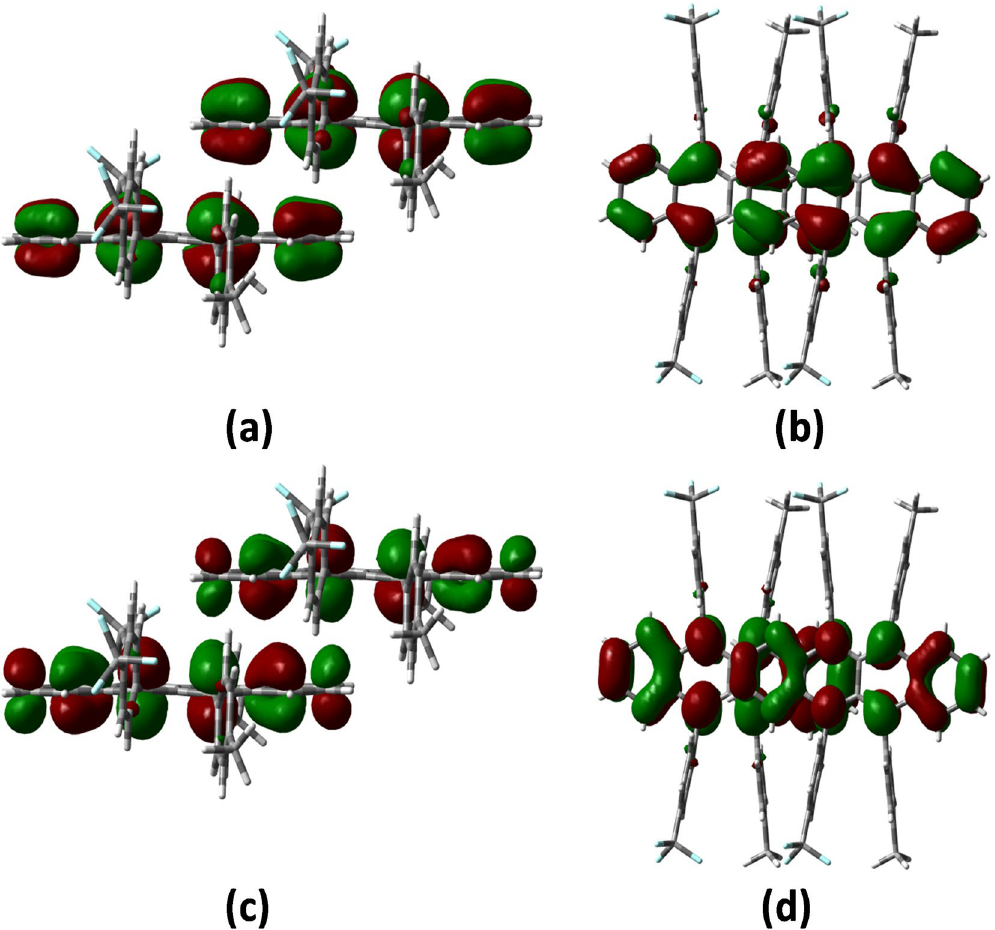
Figure 4. HOMOs (0.02 au) for P dimers of fm-rubrene in side view ( a ), and in top view ( b ); and LUMOs (0.02 au) for P dimers of fm-rubrene in side view ( c ), and in top view ( d